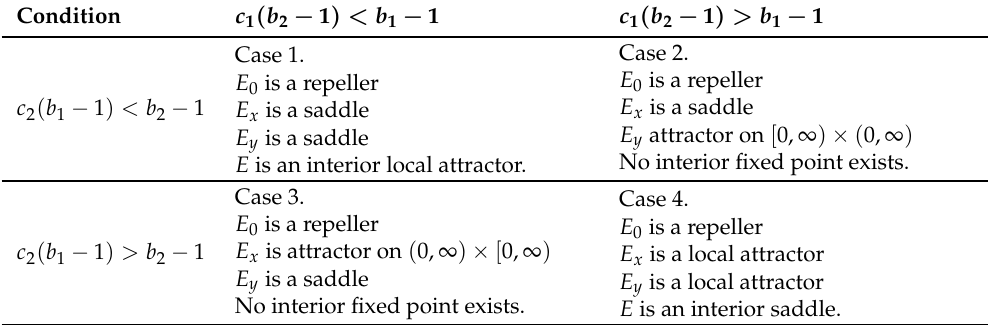
Table 1. Global behavior of solutions to Equation (1) when b 1 > 1 and b 2 > 1. Equality relations are not represented for the sake of a simpler